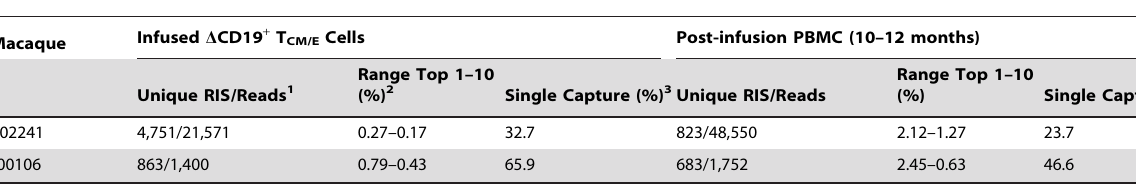
Table 1. Analysis of unique RIS in adoptively transferred and persisting CMV-specific D CD19 + CD8 + T CM/E clones.